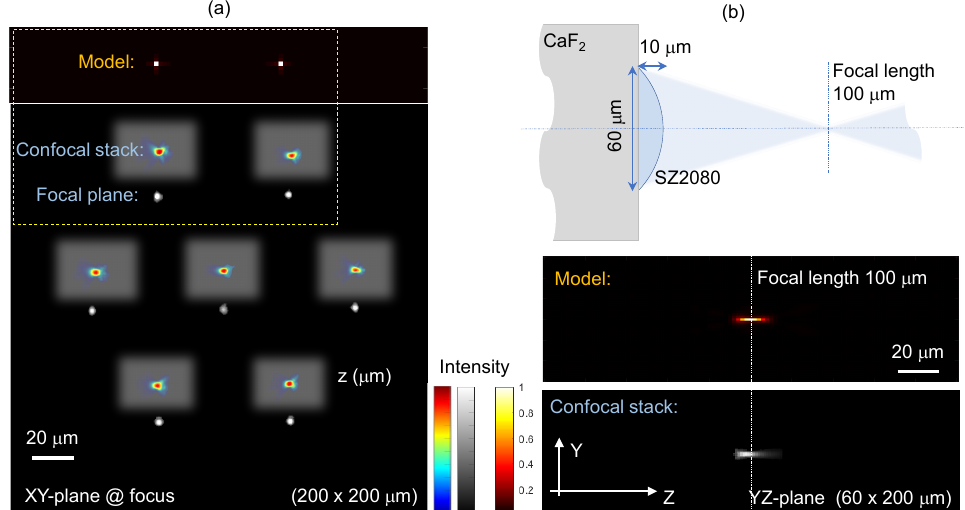
Figure 4. ( a ) Experimental measurements and simulations based on the model given by Equation (1) of the focal ( xy -plane) and axial ( yz -plane) cross-sections of the focal region intensity distribution for the MLA at a 633 nm wavelength. The cropped insets show confocally stacked intensity (normalised) at the foci. ( b ) Sketch of the lens (to scale) and the axial intensity distribution. The 3D intensity was confocally mapped through stepping microscope imaging along the z -axis by 1 µ m and the MATLAB programming code was used to stack them for cross-sectional views. The colour bars represent the normalised